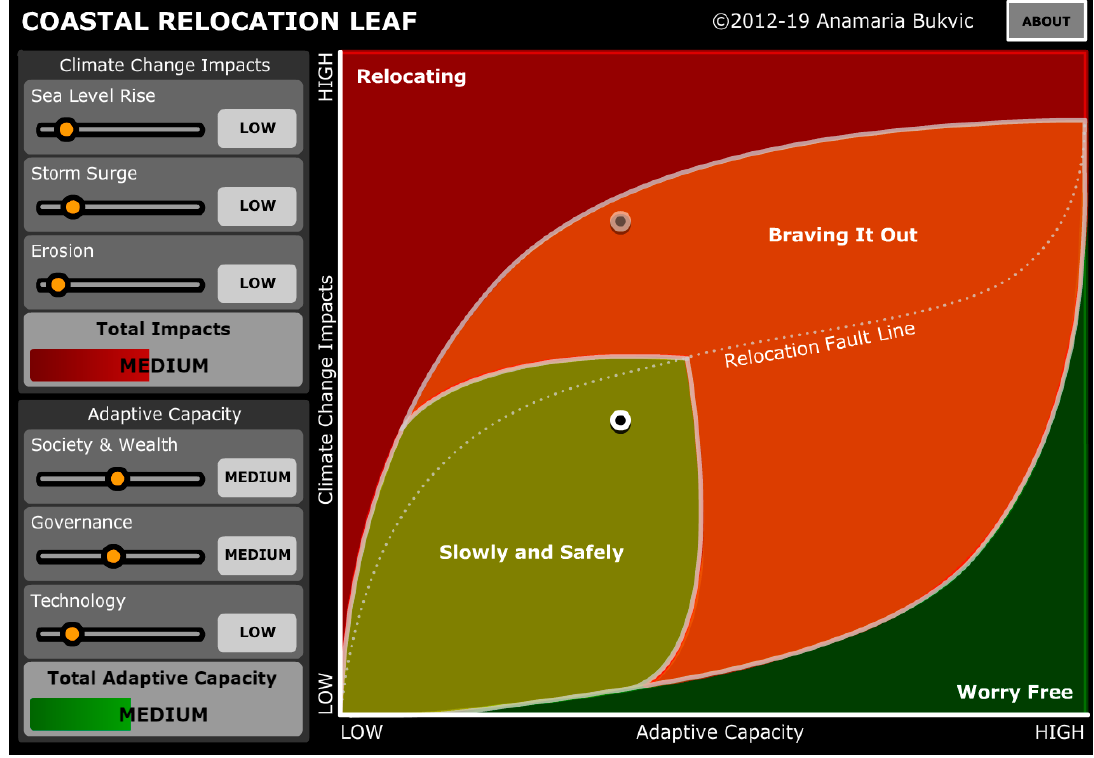
Figure 1. Coastal Relocation Leaf (CRL).